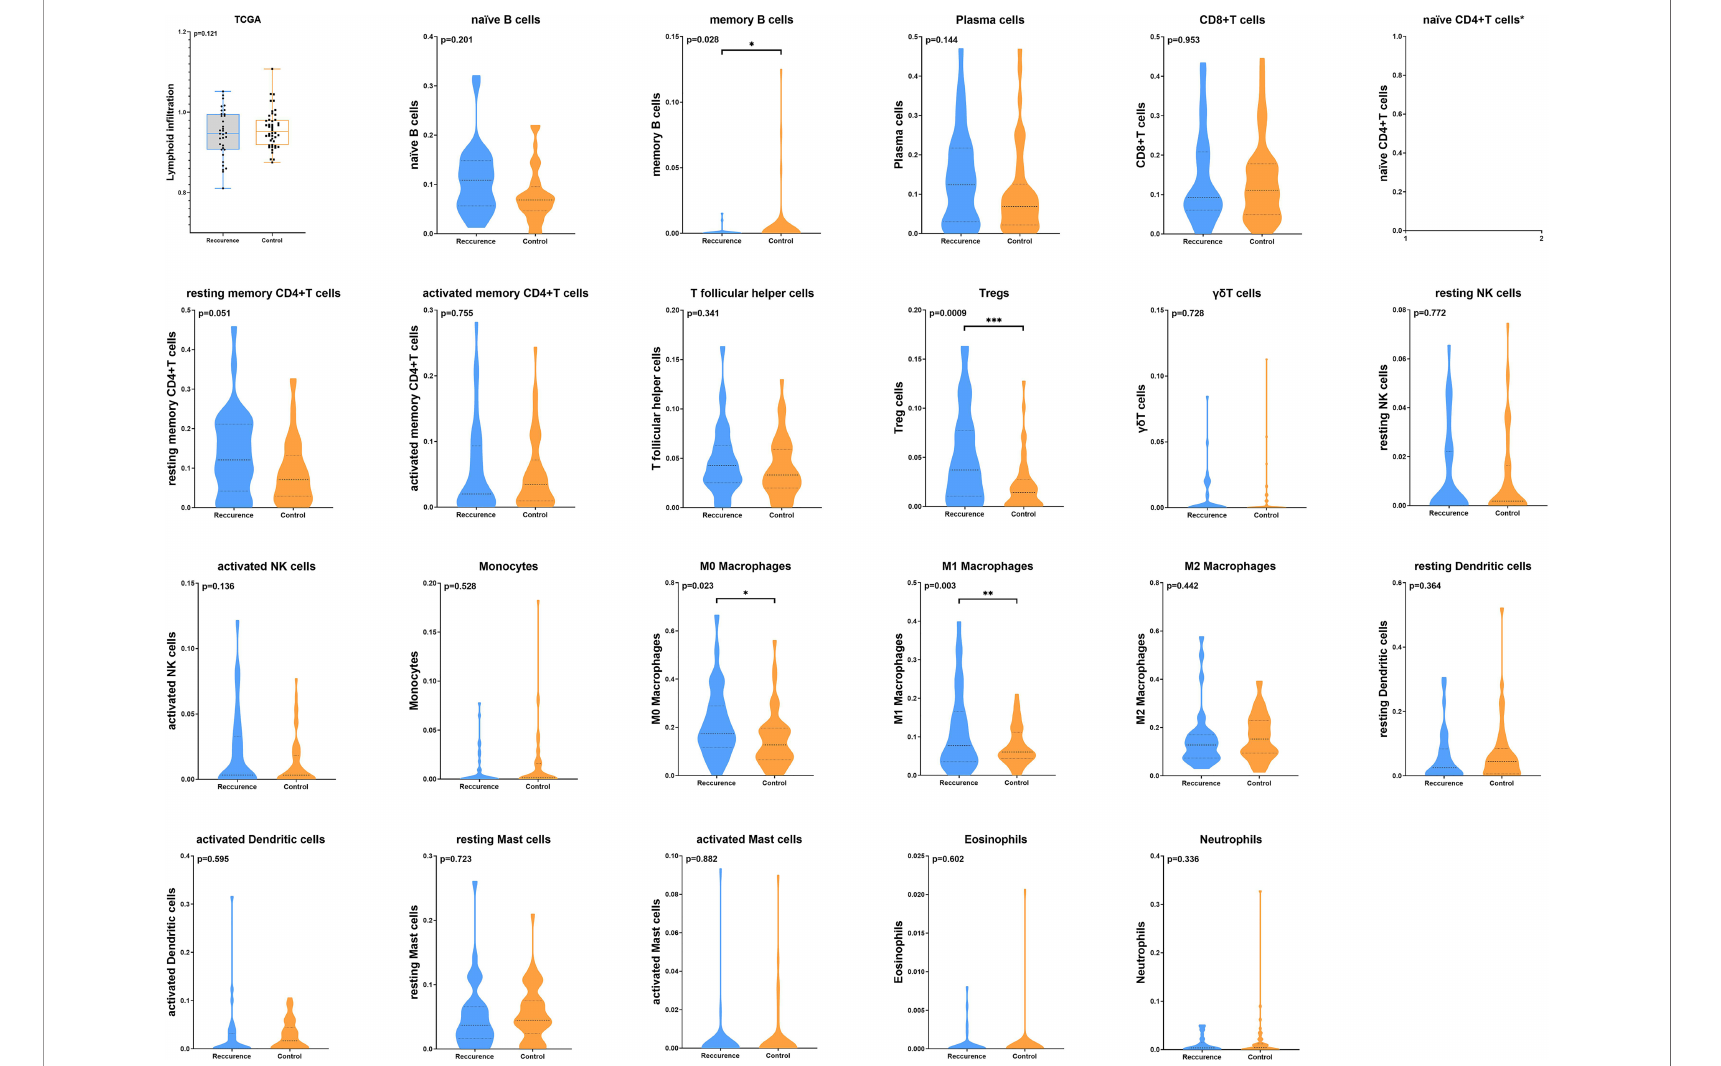
FIGURE 1 | The distribution of in fi ltrating immune cells in the tumors from TCGA training cohort. CIBERSORT analysis demonstrated that the total number of in fi ltrated lymphocytes was similar between the two groups (p = 0.12). Among 22 tumor in fi ltrating lymphocyte types, Tregs, M0 and M1 macrophages signi fi cantly enriched in tumor tissues in the recurrence group, while memory B cells were more frequently detected in controls (*p < 0.05; **p < 0.01; ***p < 0.001). CIBERSORT analysis failed to generate the in fi ltration status of naïve CD4 + T